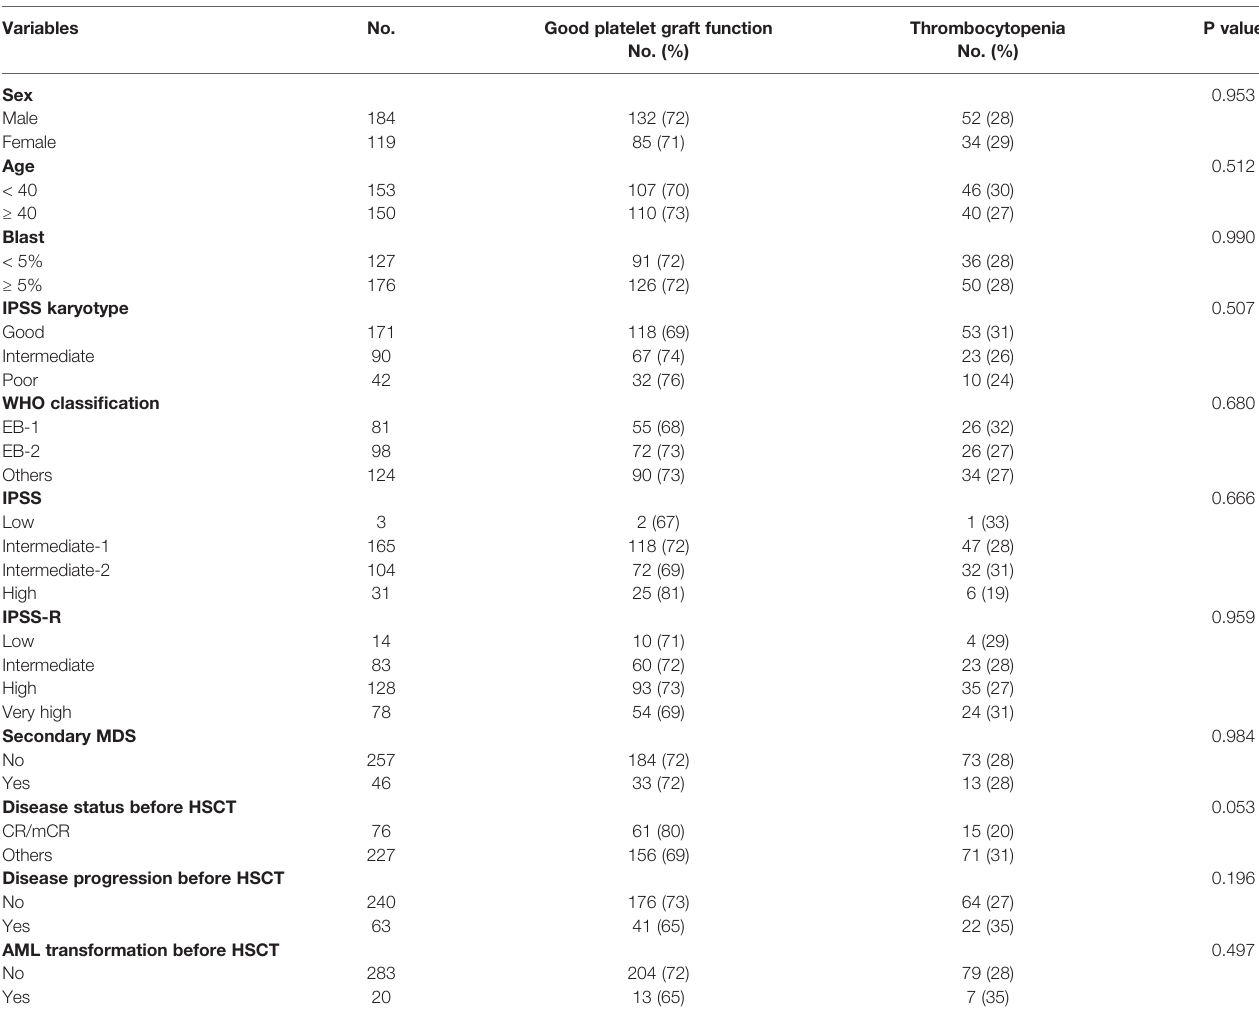
TABLE 1 | Patient